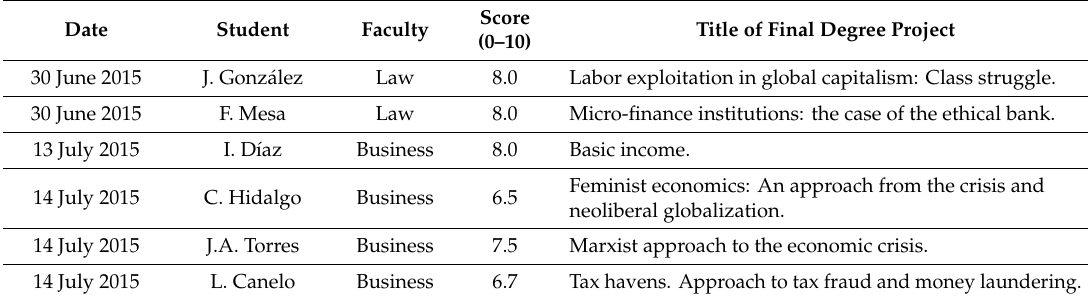
Table 4. Heterodox economic approach FDPs, University of Extremadura (UEx),